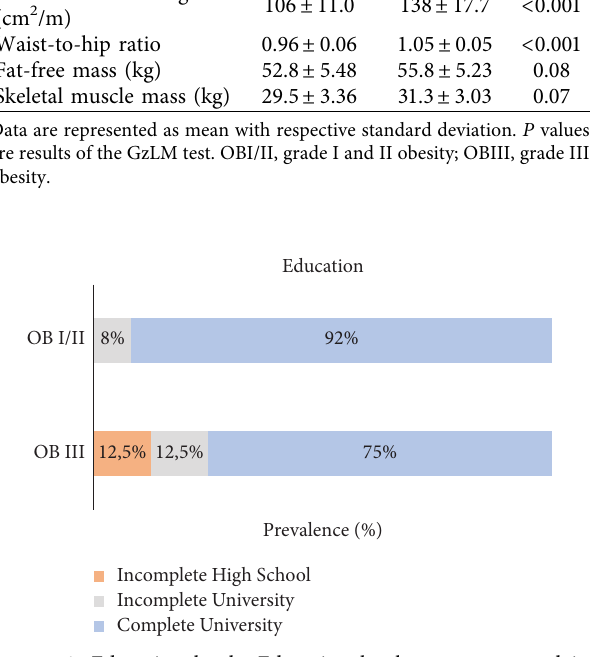
Figure 2: Education levels. Education levels were converted in ordinal variables and the Mann–Whitney test was applied, P > 0 . 05. Table 2: Score of cognitive tests.